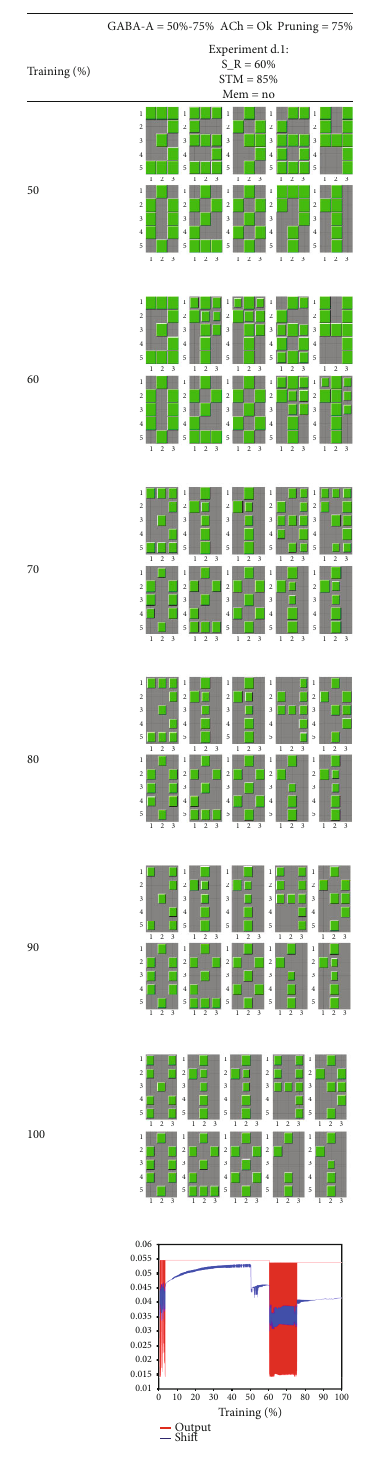
Figure 11: This table presents a case in which GABA-A normalization is recovered despite the usual process of network aging. After the elimination of GABA-A normalization that occurred at 50% of epochs, pattern learning was impaired; that is to say, patterns were poorly recovered, and neurons lost their pattern speci fi city. With the reduction of sensory stimuli at 60% of epochs, the average shift and output started an intense oscillatory dynamic that suddenly disappeared when GABA-A normalization was reinstalled at 75% of repetitions. After this recovery, the network was capable of learning pattern X, while the recovery of the remaining numerical patterns was damaged. At this later stage, in which many of the connections were pruned, learning is a di ffi cult process requiring much more repetitions than in an intact network. Labels: S_R=sensory reduction; STM =short-term memory; Mem =memantine; ACh =acetylcholine reduction in thalamocortical